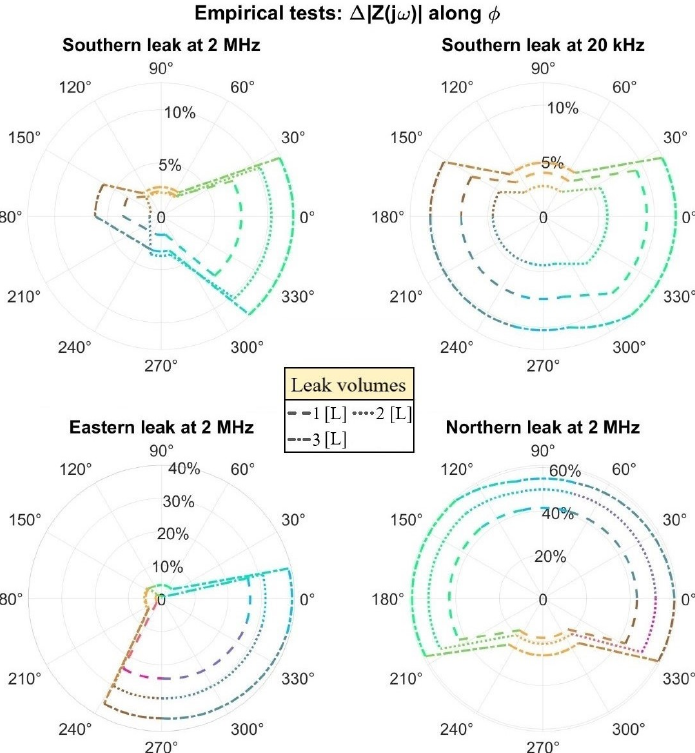
Figure 18. Polar plots attained for ∆ |Z(j ω )|, evaluated throughout the φ cylindrical coordinate for three distinctly localized leakage sources. In each of them, the four cardinally oriented triplet gauged values are interpolated along intermediate shared regions when sufficiently contiguous or depicted by steep lines otherwise, being represented by the vicinities’ averaged colors in both cases.